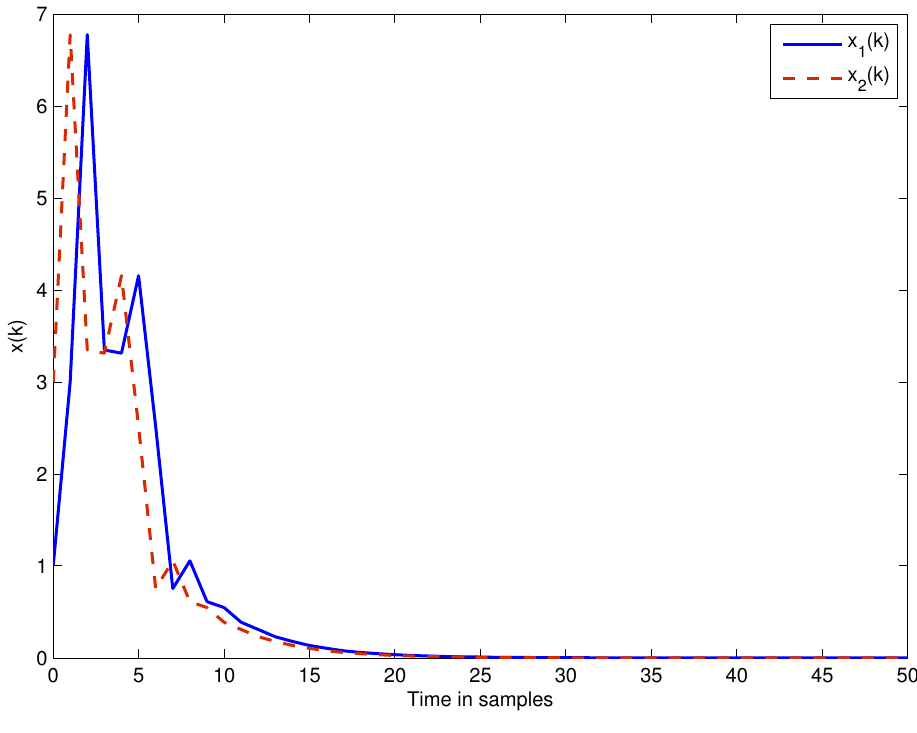
Figure 4. State response of the closed-loop